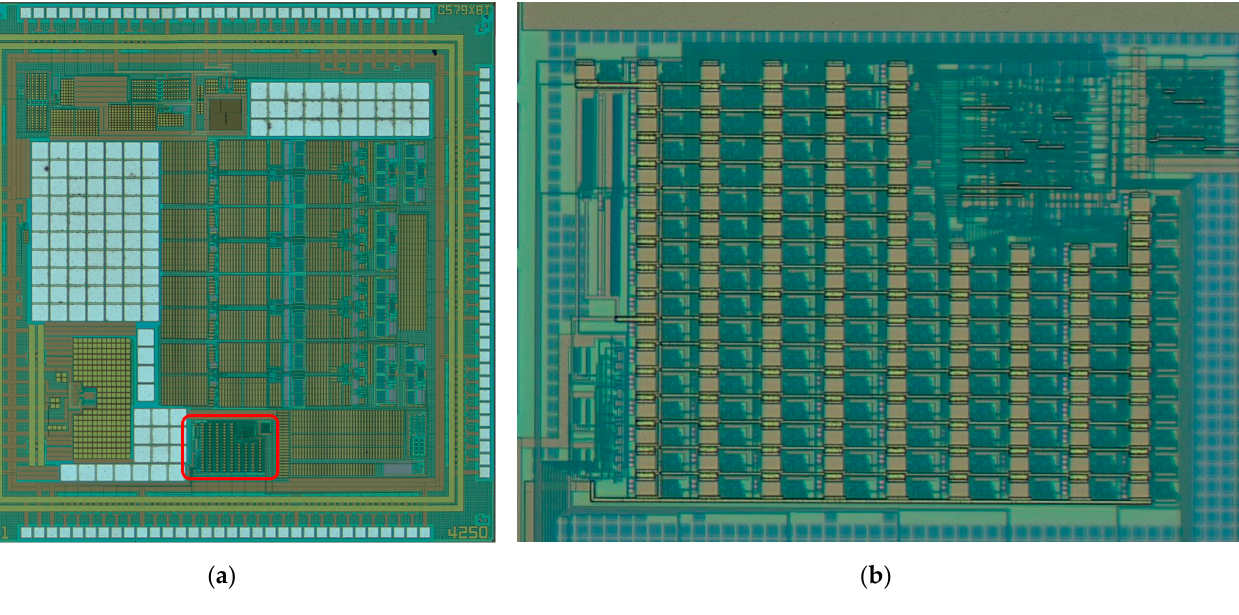
Figure 20. Chip fabrication result: (a) Real chip view; (b) microscopic view of the flash ADC only.